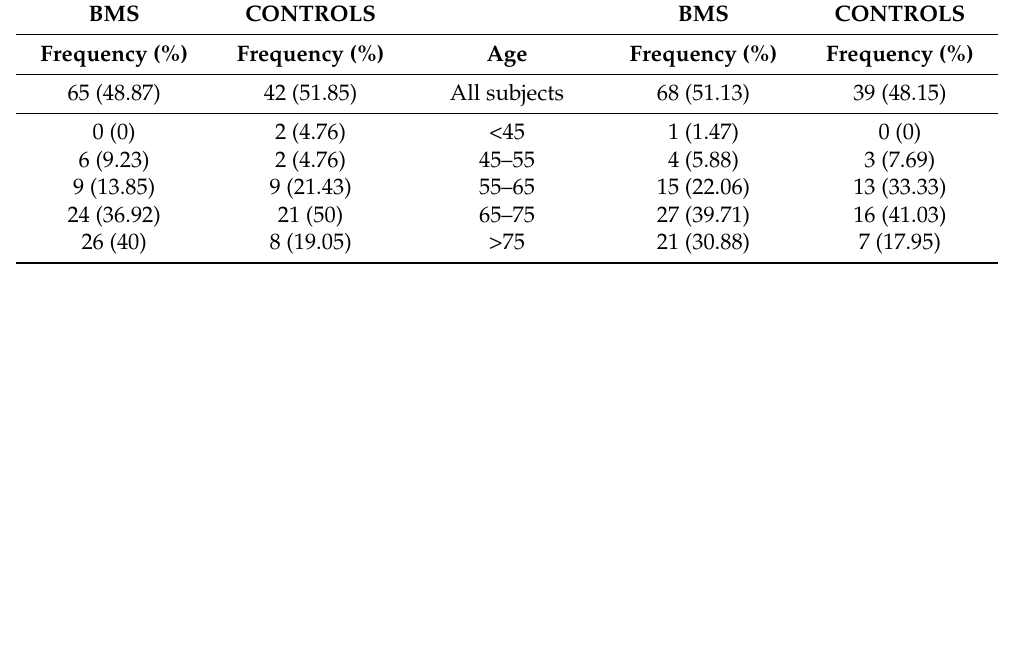
Table 3. Frequency distribution of HTN by age range and gender of 133 BMS patients and 81 controls. Male